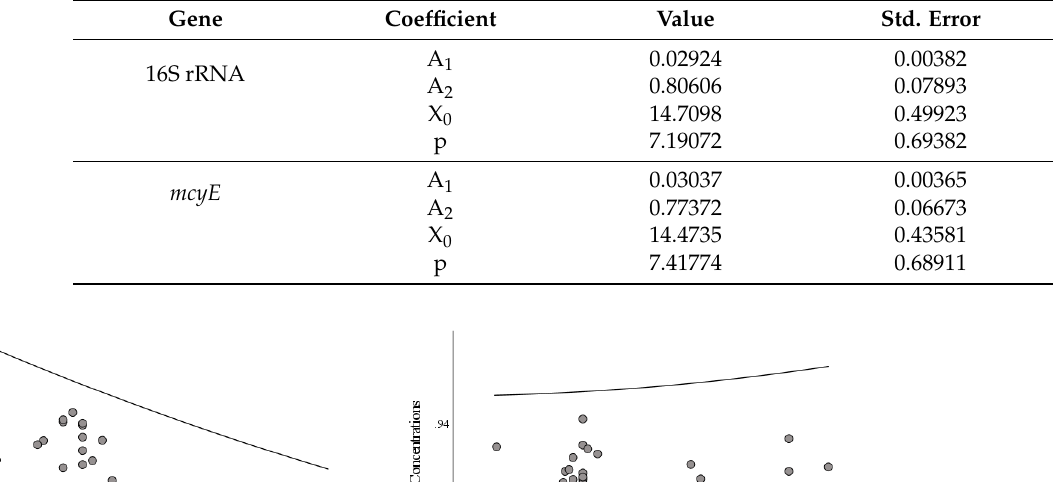
Table 3. Coefficients for GLM equation predicting ratio of near-surface/near-bottom gene concen- trations with depth. Gene Coefficient